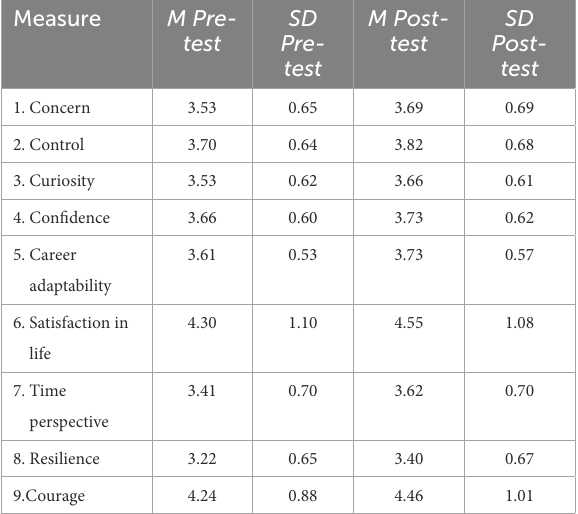
TABLE 2 Means and standard deviations at pre- and